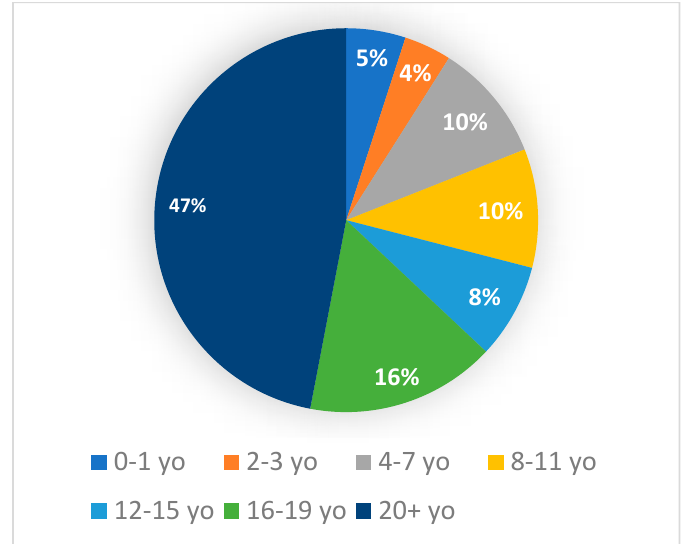
Figure 3. Distribution of companies by age of the company.